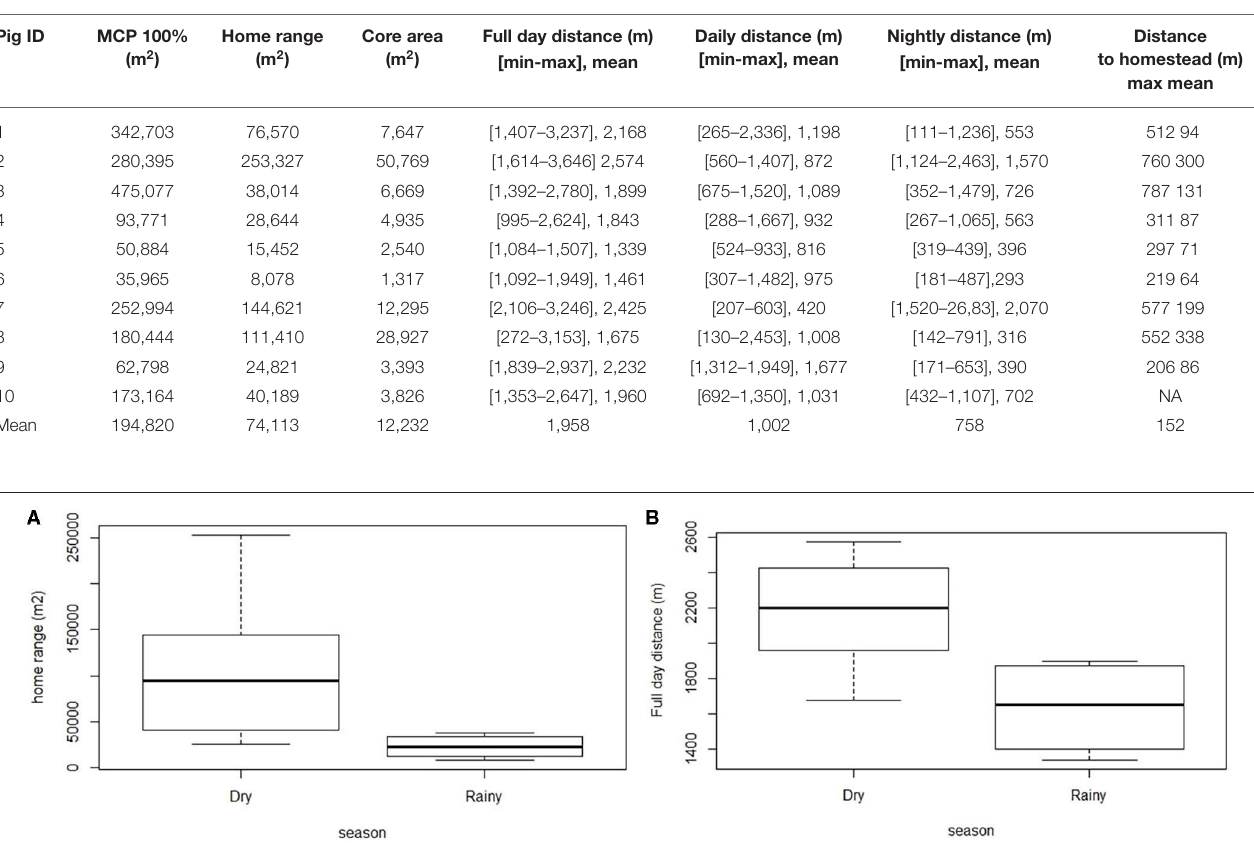
TABLE 2 | Details of the movements of the ten collared pigs.